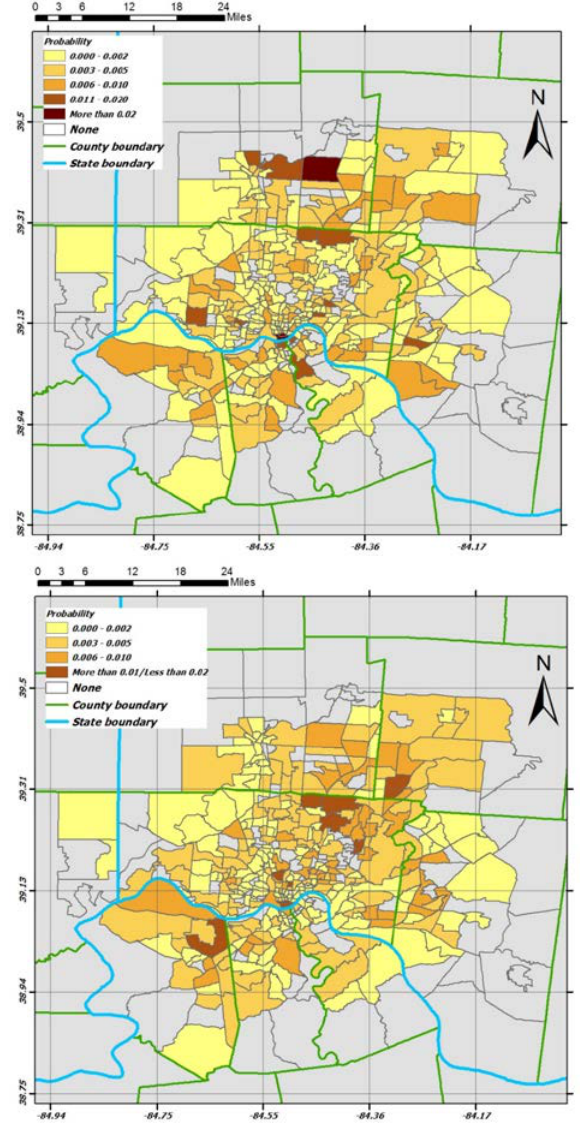
Figure 10. Probability of selecting each tract as the destination calculated by model based OD matrix (top) and survey based OD matrix